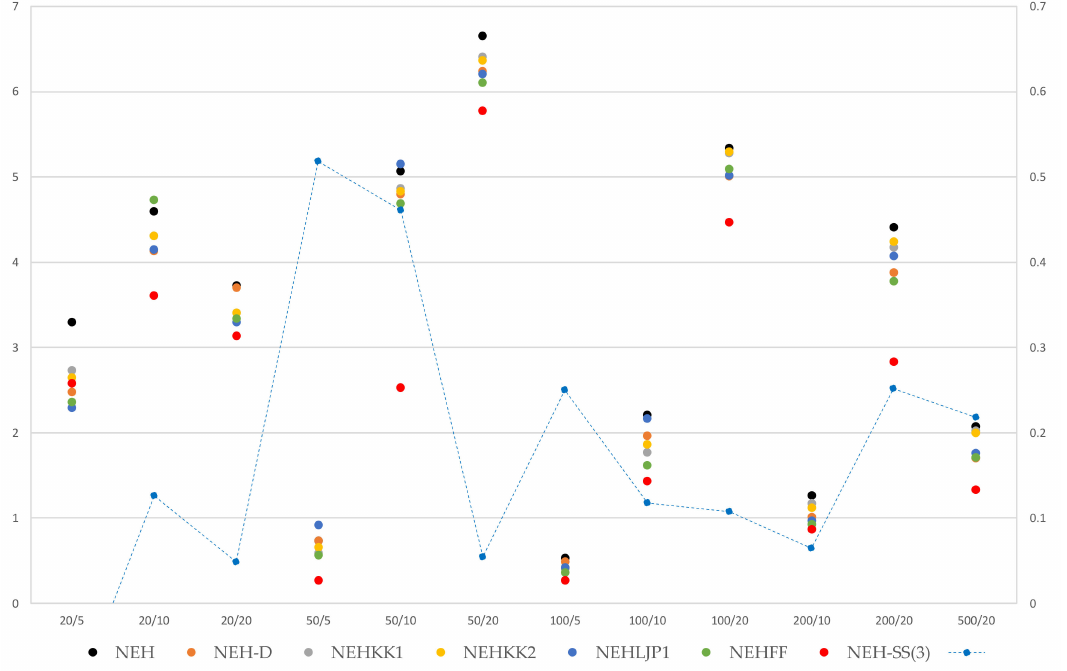
Figure 3. ARPD (in %) of di ff erent improvement methods compared to Taillard’s benchmark problem sizes, and improvement percentage over the best of the other heuristics (in dotted line, secondary